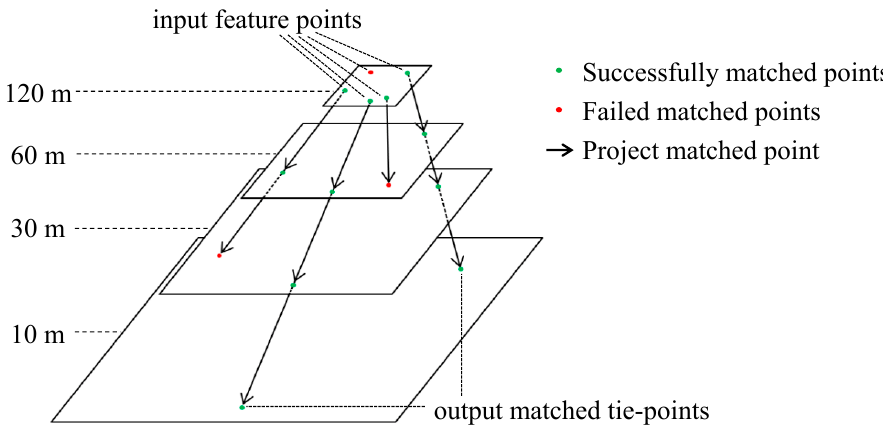
Figure 4. Illustration of depth-first LSM mismatch detection on the four-level image pyramid (shown for the Sentinel-2A image only).